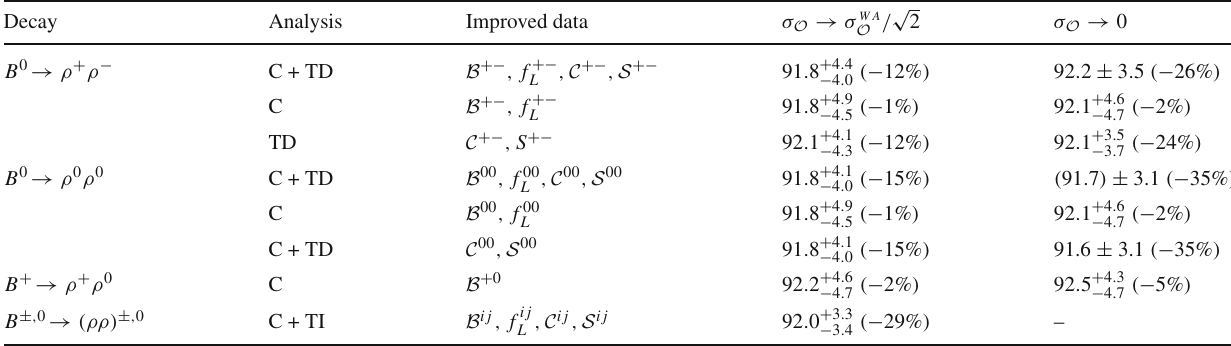
The relative gain in resolution with respect to the current measurement is indicated within brackets. Only the preferred solution for α close to 90 ◦ is